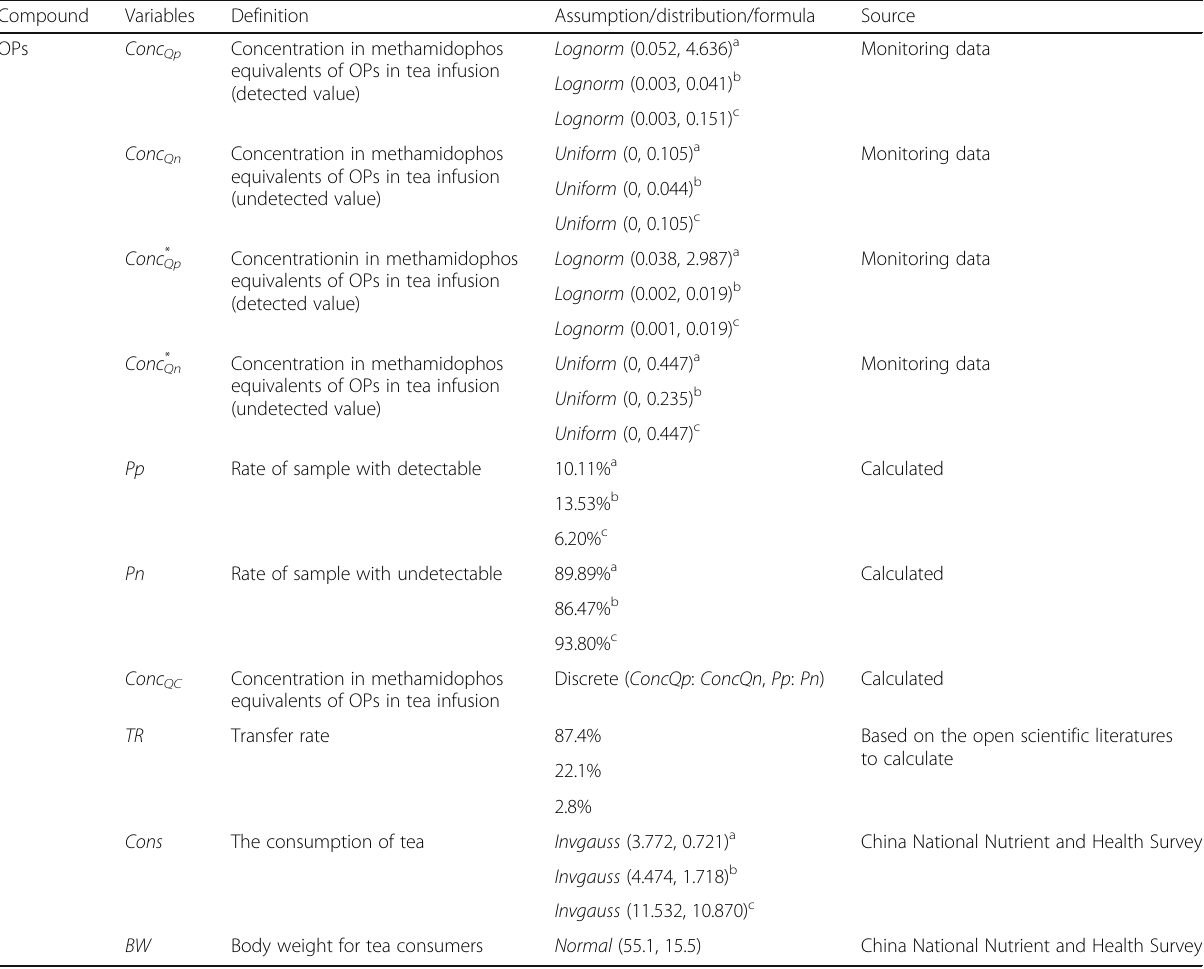
Table 1 Description and distribution of variables and models for dietary exposure assessment of OP residues in tea infusion